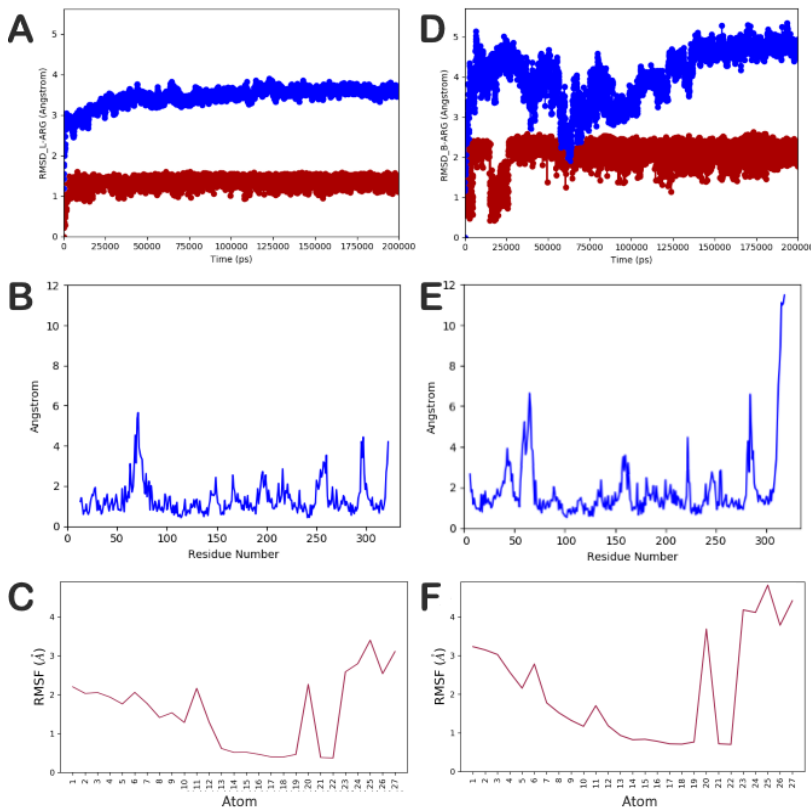
Figure 5. ( A – C ) Root-mean-square deviation (RMSD) and RMSF of the protein and the ligand, respectively, found for the complex compound 14 / L-ARG; ( D – F ) RMSD and RMSF of the protein and the ligand, respectively, found for the complex compound 14 / B-ARG. The pictures were generated by MD tools analysis implemented in